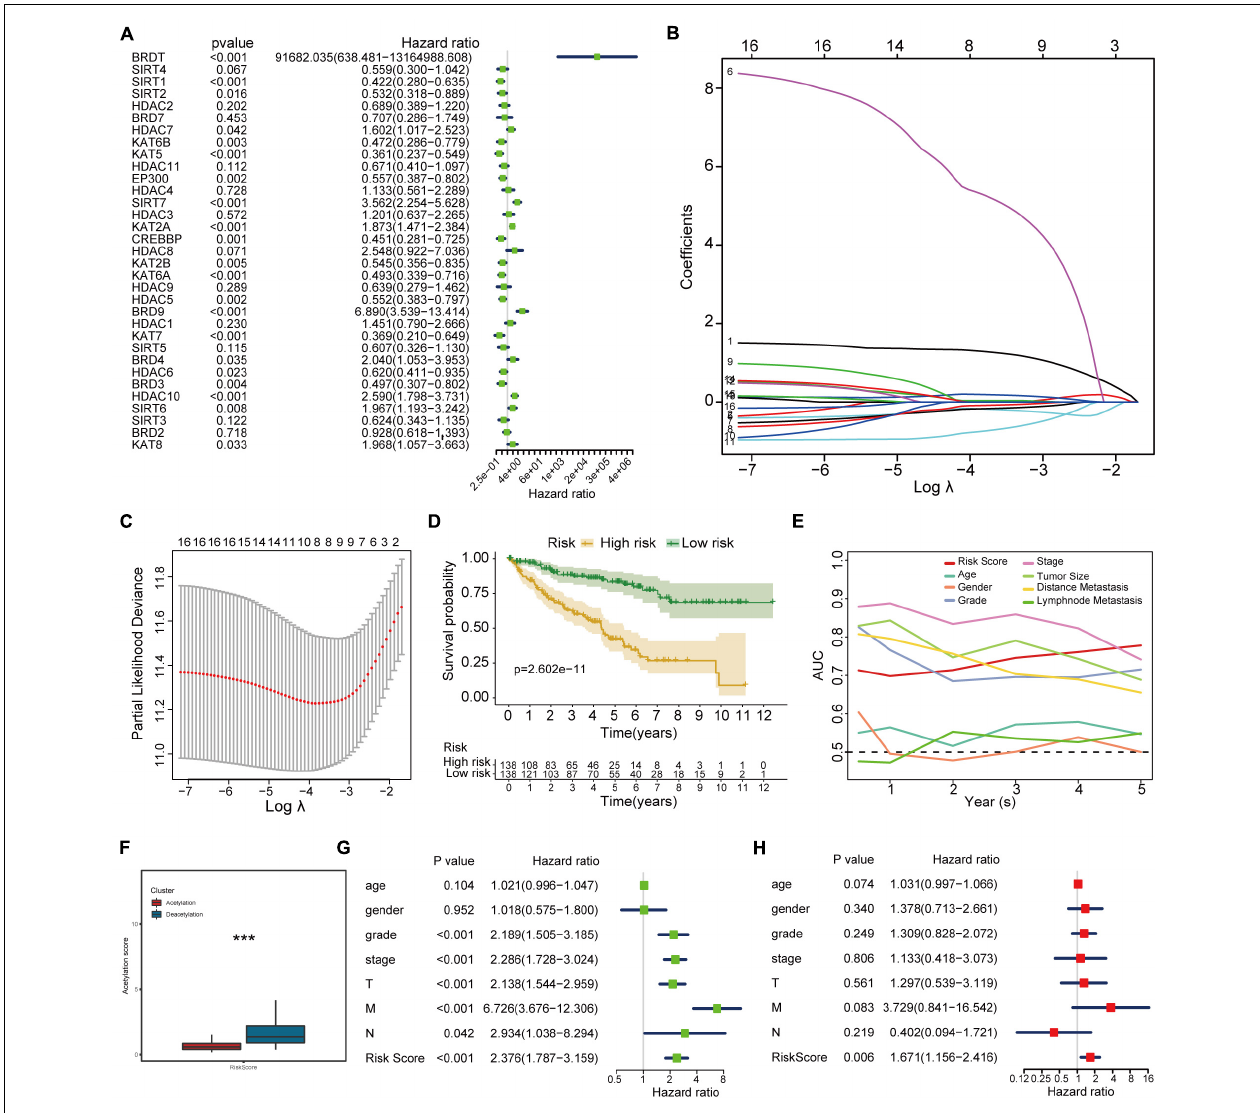
FIGURE 5 | Histone acetylation-related score construction and validation. (A) Results of univariate Cox regression analysis. (B,C) Results of lasso regression analysis. (D) Survival analysis between high-risk and low-risk groups. (E) ROC analysis including established score and other clinical parameters from 1 to 5 years. (F) Correlation between established subtypes and acetylation-related score. (G,H) The results of univariate and multivariate Cox regression analysis. *** p < 0.001.